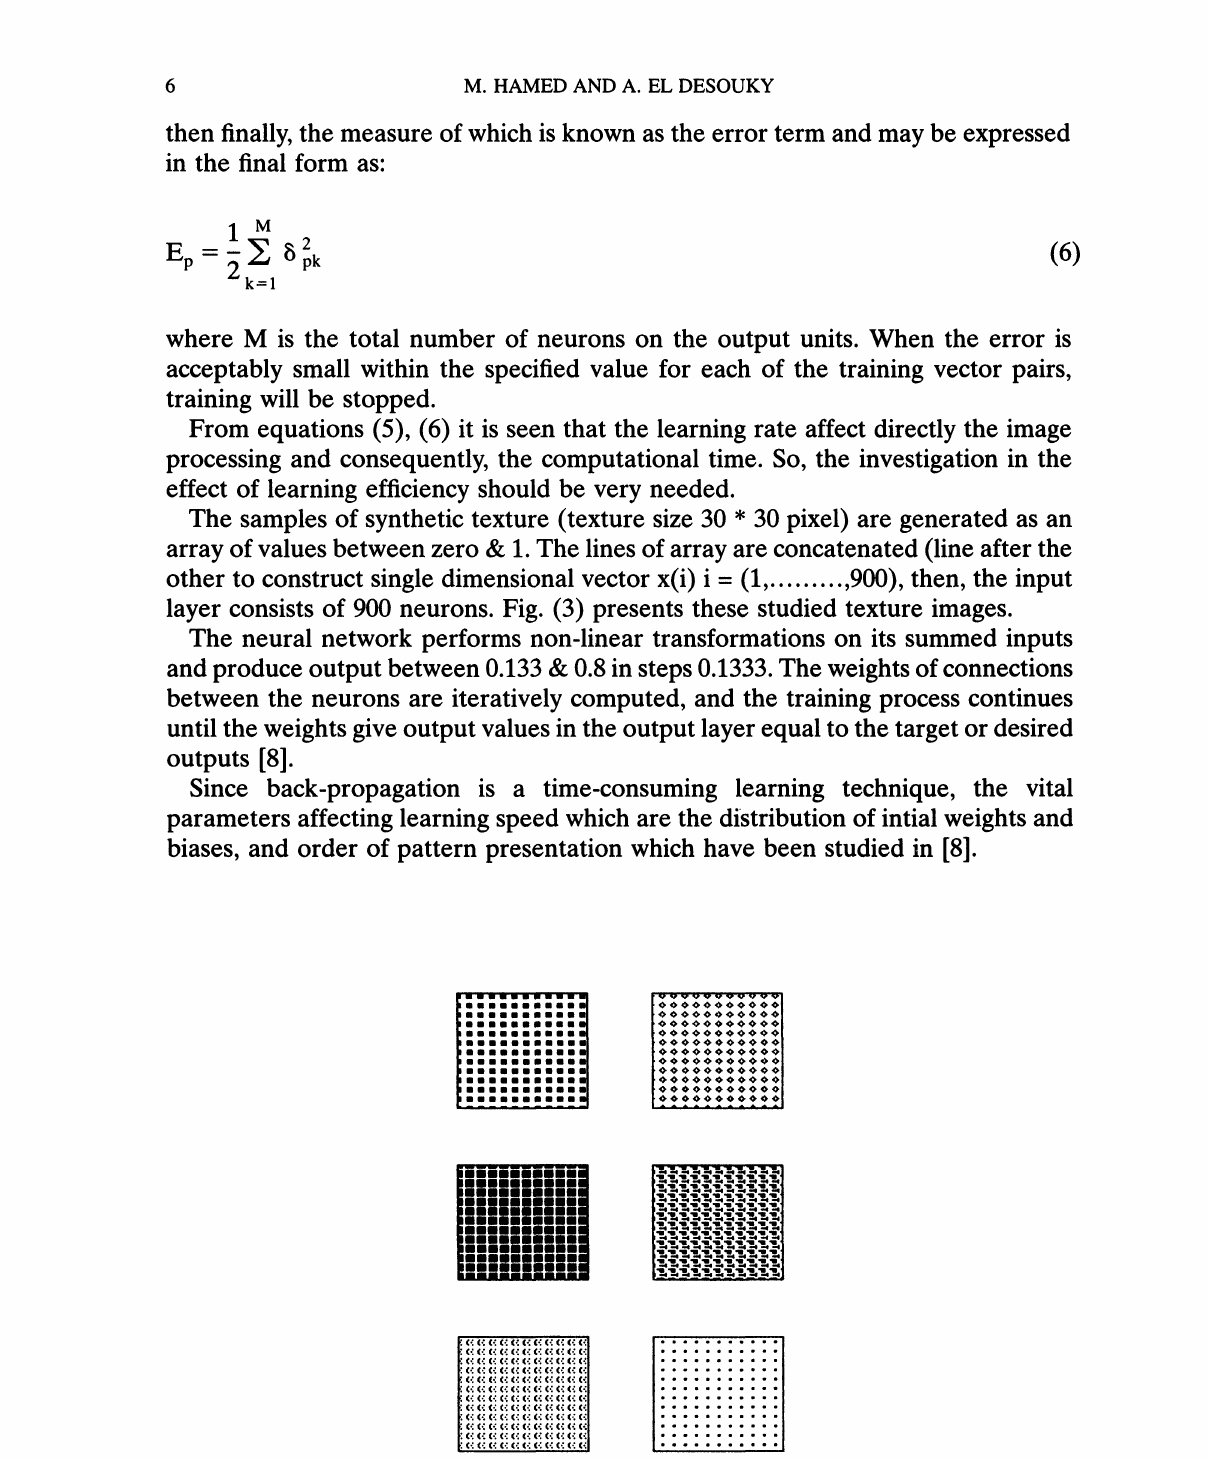
FIGURE 3 Different shapes of synthetic